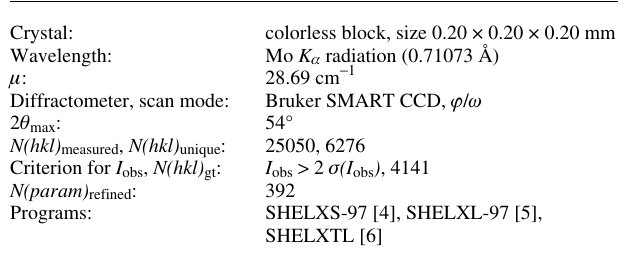
Table 1. Data collection and